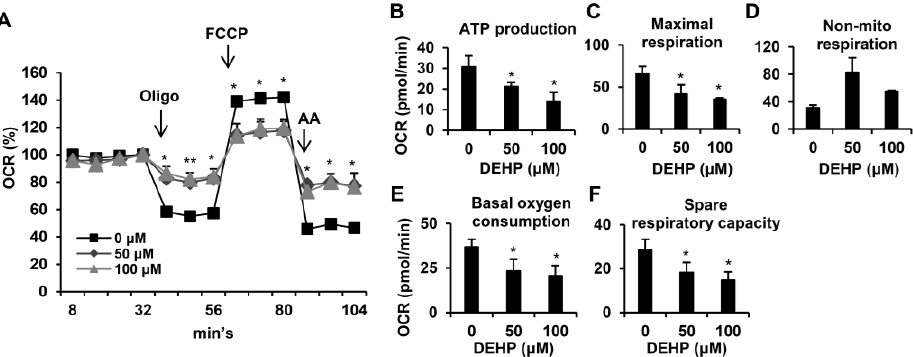
Figure 6. E ff ects of long-term, low-dose DEHP exposure-induced mitochondrial dysfunction in HSC-T6 cells. ( A ) Mitochondrial respiration functions were analyzed by the Seahorse XFe Extracellular Flux Analyzer. Oligomycin (Oligo, 1 µ M), FCCP (2 µ M) and rotenene / antimycin A (AA, 0.5 µ M) were injected into the well at the fourth, eighth, and 11th time point. Quantitative data are shown in ( B – F ). * p < 0.05; ** vs. 0 µ